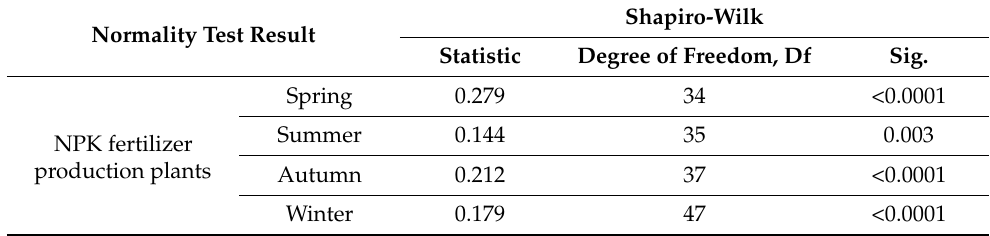
Table 4. The result of the normality test of NH 3 concentrations at NPK fertilizer production plants.